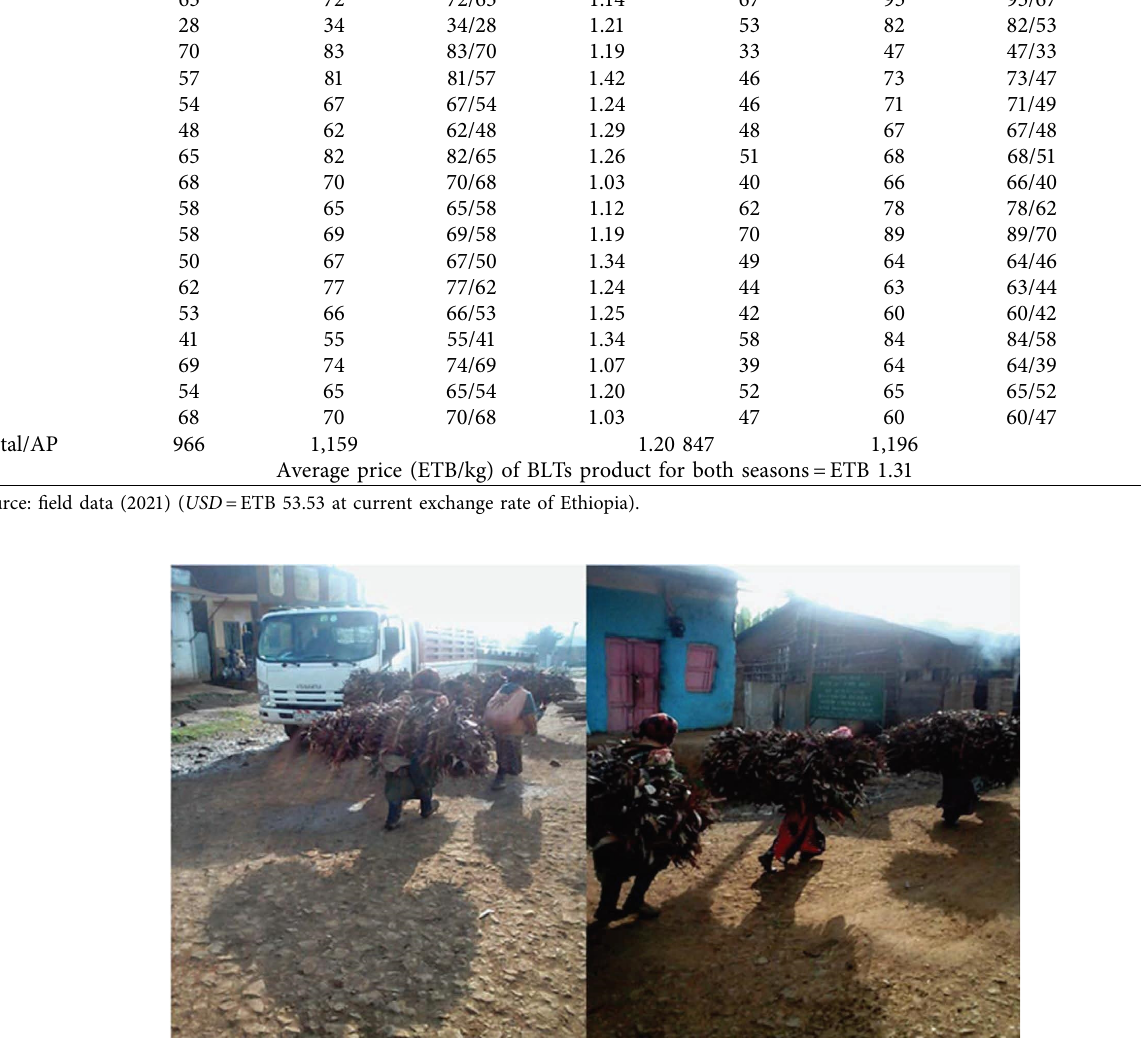
Figure 5: Women carrying bundles/bales of litter to Chencha town during the dry season (source: photo flmed with their consent in December